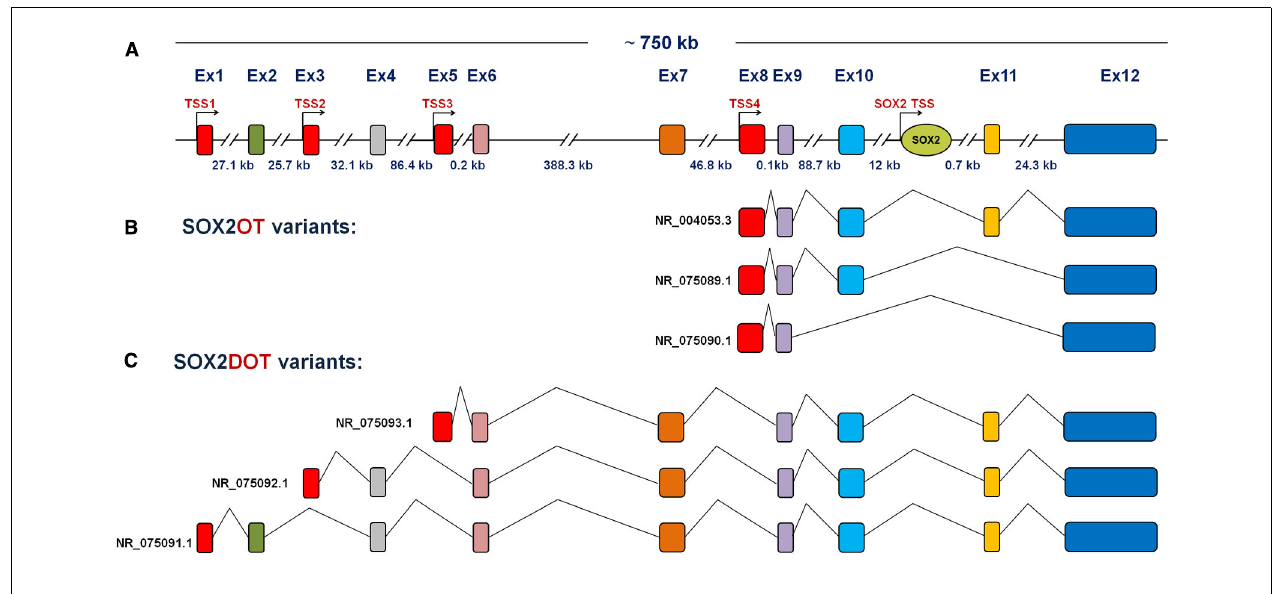
FIGURE 3 | Schematic representative of human SOX2OT gene and its splicing patterns. (A) Multi-exon gene of SOX2OT is located on human Chr3q26.3 and is extending in a 750 kb genomic region, where it holds the